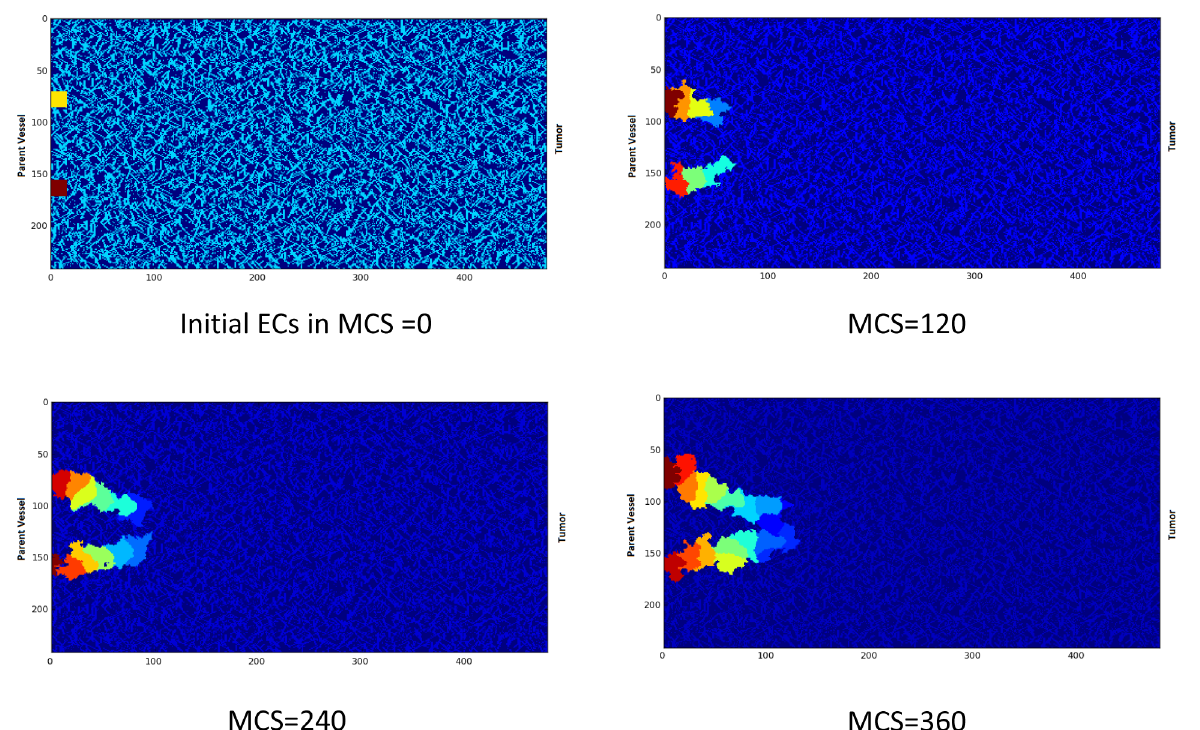
Fig 8. Closed loop formation in the model. The X and Y-axis show the domain size in μ m. conditions, a single closed loop is obtained once and is used as the starting point of the model in different conditions, i.e. the model does not start from two single ECs every time, rather the model starts from the closed loop every time. The closed loop formation steps are shown in Fig 8. Cell phenotype alteration due to flow in the loop When blood flows in the closed loop, it acts as the main regulator of cell phenotype. ECs are ac- tivated by shear stress magnitudes as low as 0.2 dyne/cm 2 [64,67]. Activation means that both In cell phenotype determination before loop formation, apoptosis is dominant cell pheno-